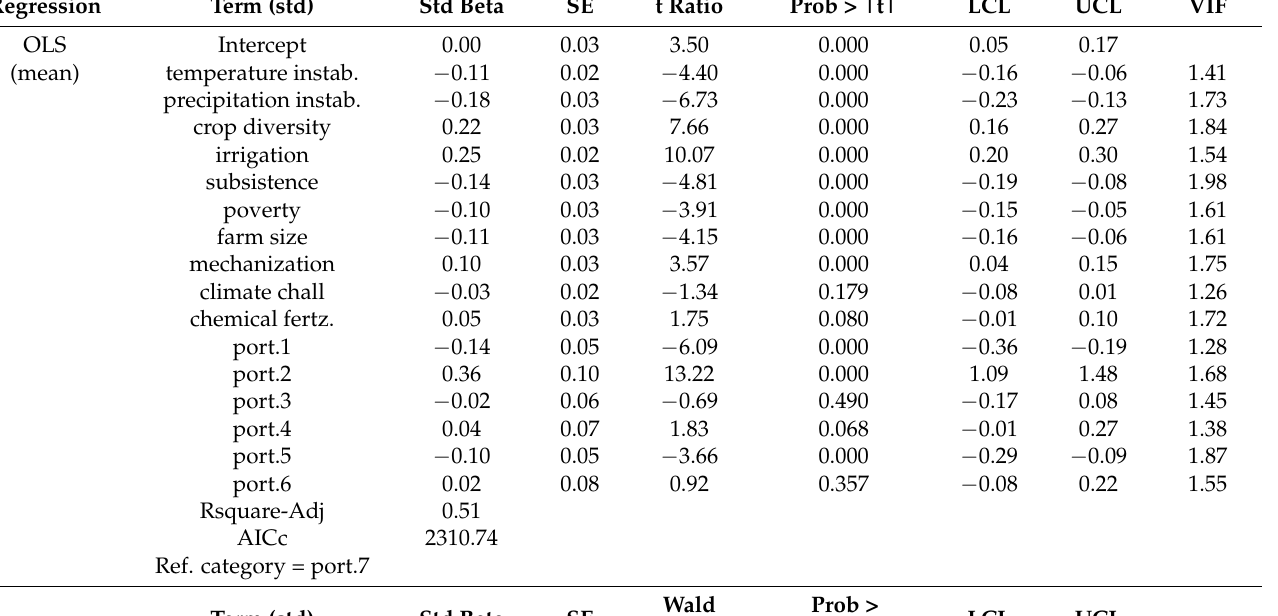
Table A4. Results of Model 3, ordinary least squares (OLS) and quantile (median) regressions.